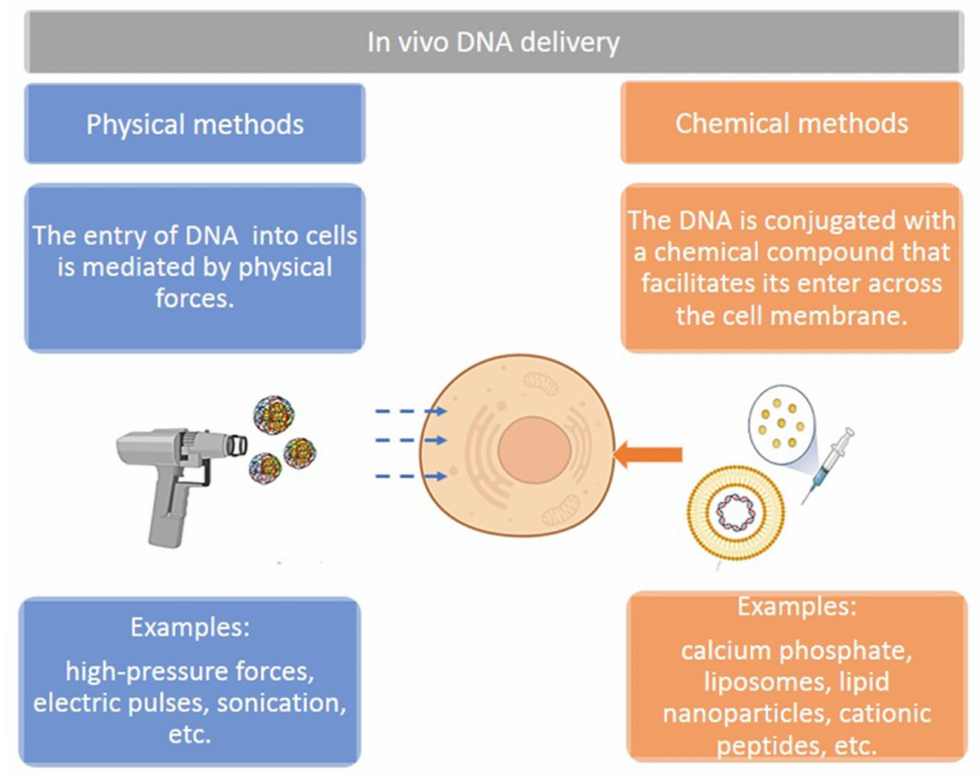
Figure 4. Different strategies using plasmids for therapeutic purposes. DNA delivery methods can be divided into physical- and chemical-mediated methods. Figure created in